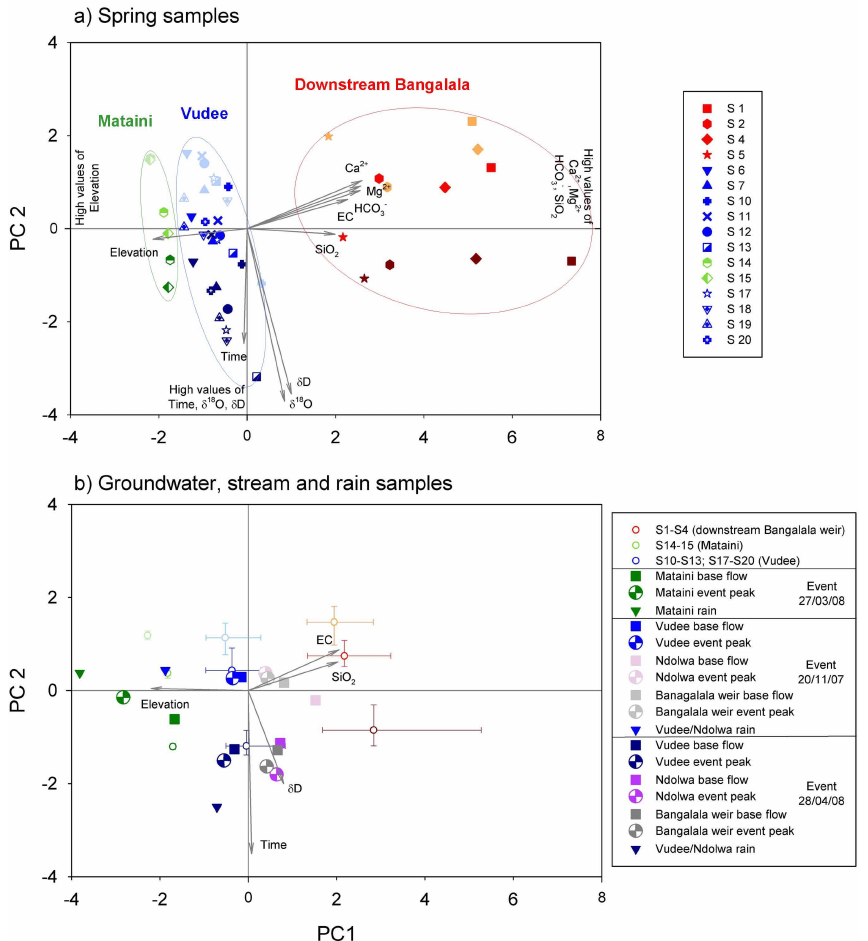
Fig. 4. (a) shows a Principle Component Analysis (PCA) based on elevation (as a proxy for location) and time elapsed since start of WS1 as well as on the geochemical (Ca 2 + , Mg 2 + , HCO − , SiO 2 , EC) and isotopic ( δD , δ 18 O) composition of spring water samples (S1–S20) 3 at three sampling dates at the beginning of WS1 (10/2007), the end of WS1 (12/2007) and in the middle of WS2 (04/2008). The different symbols represent the different springs while the different shades represent the sampling date, i.e. points with lightest shade were sampled at the first occasion (10/2007), the points with the darkest shades were sampled at the last occasion (04/2008). (b) shows a PCA based on a reduced data set, as the complete geochemical and isotopic signature of stream water samples was not available for all samples. It is thus based on elevation (as a proxy for location) and time elapsed since start of WS1 as well as on the geochemical (SiO 2 , EC) and isotopic ( δD ) composition of the mean and 95% inter-quantile ranges of the spring samples (S1–S20), the composition of baseflow, peak event flow and event rain samples at Mataini, Vudee, Ndolwa and Bangalala, sampled during 2 events (20/11/2007 and 28/04/2008). Lighter shades indicate earlier dates, while darker shades again indicate events later in the study